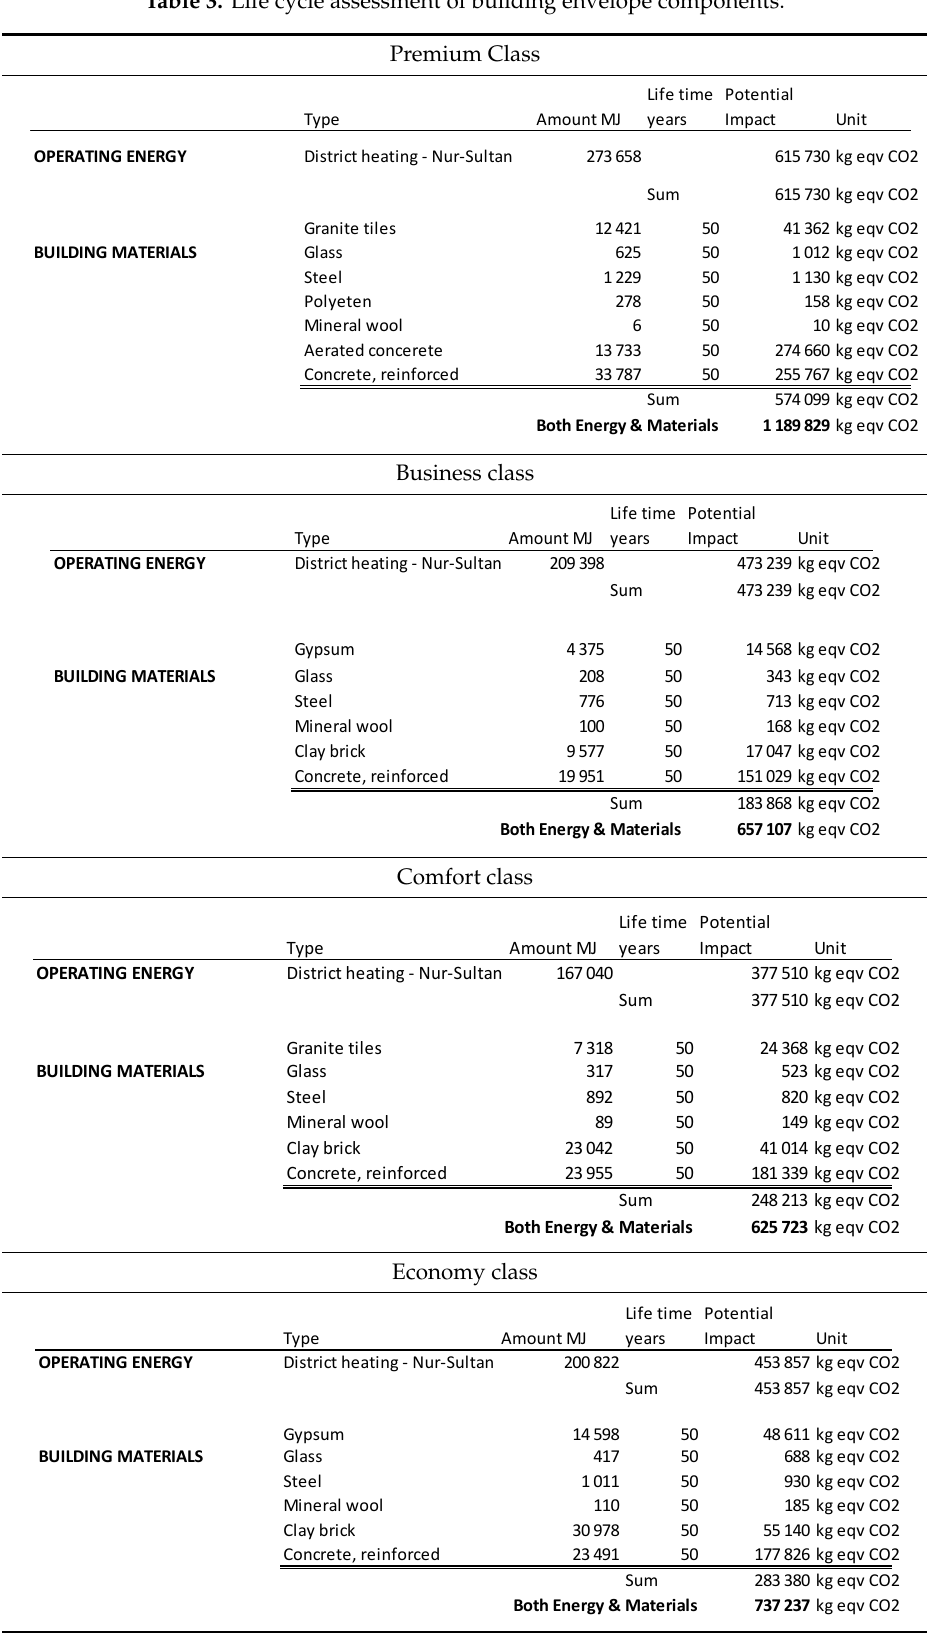
Table 3. Life cycle assessment of building envelope components.